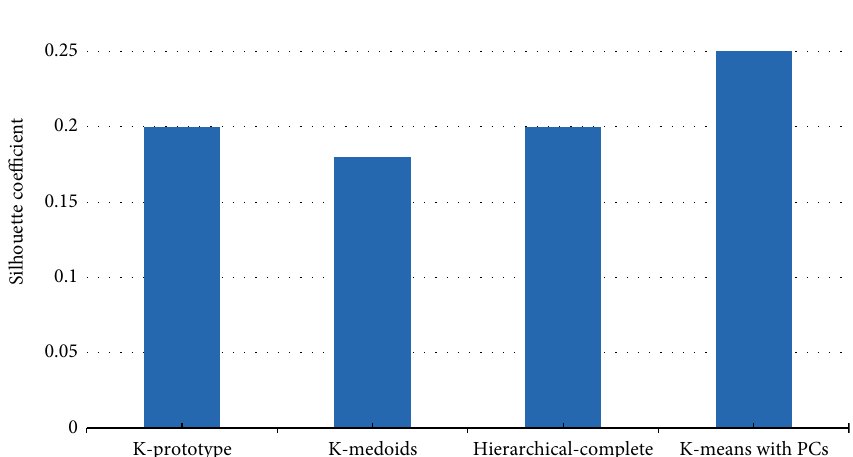
Figure 5: Silhouette coefficient for different clustering methods for the seven